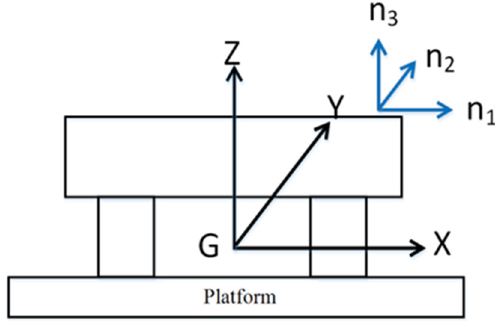
Figure 15. The coordinate system used in this paper.